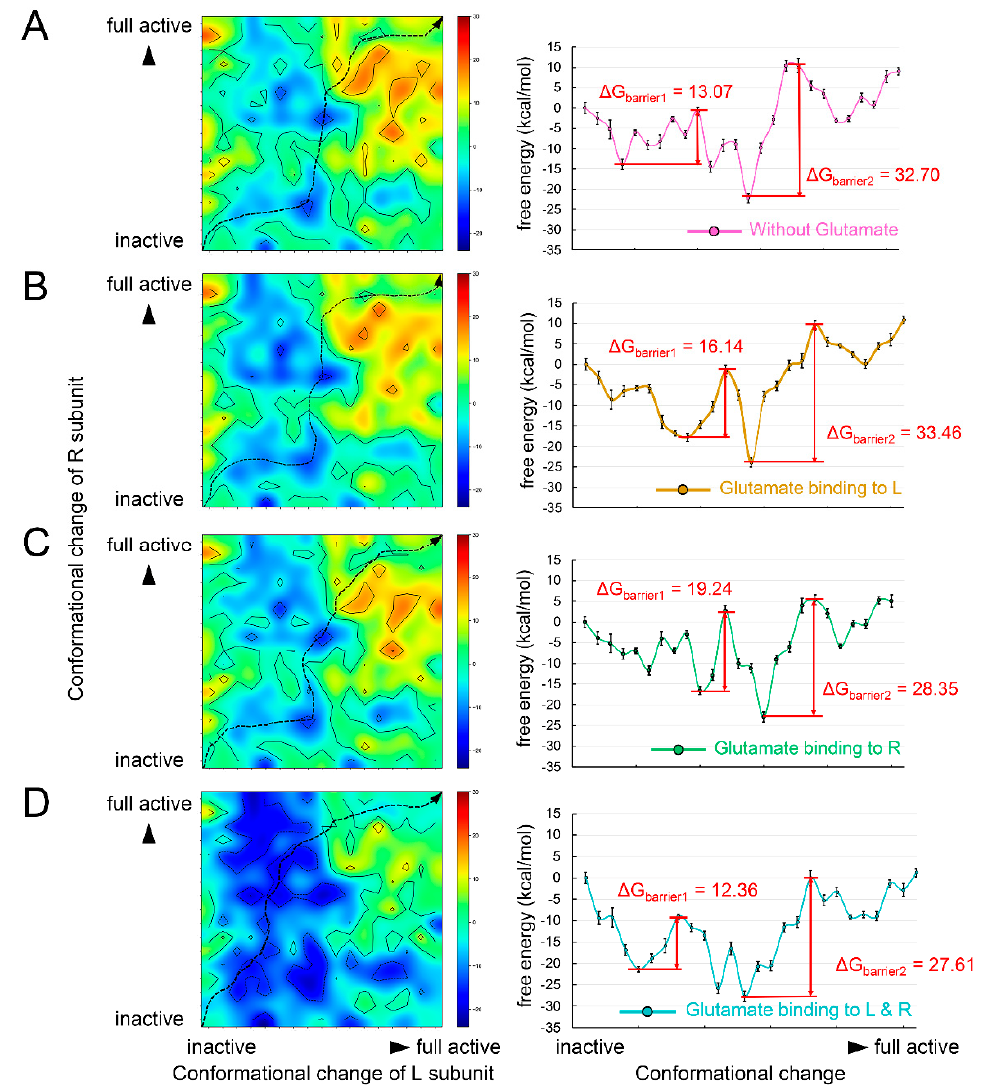
Figure 4. The energy maps of the two–dimensional conformational change system and the energy landscapes of its least energy pathway under the conditions ( A ) without any glutamate binding, ( B ) with glutamate binding to the L subunit, ( C ) with glutamate binding to the R subunit, and ( D ) with 2 glutamates binding to the L and R subunits.